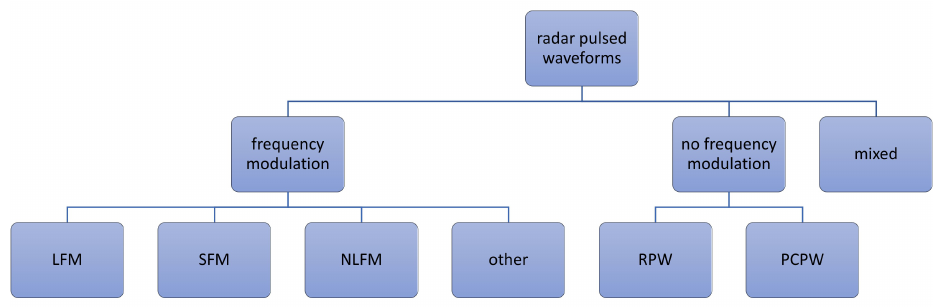
Figure 1. General division of radar